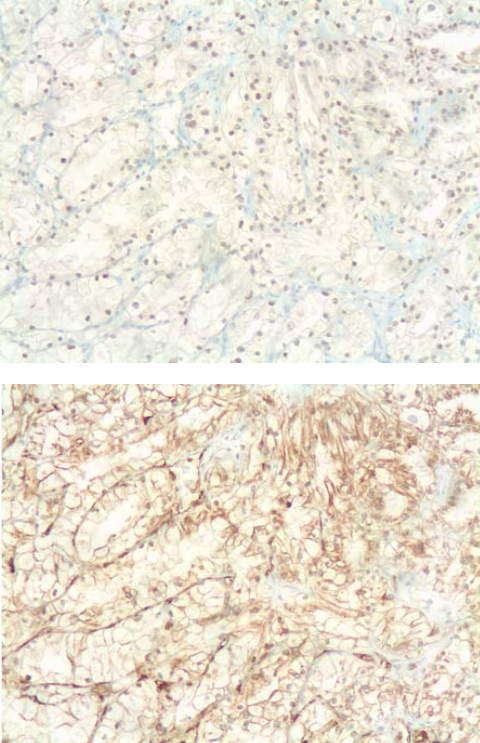
Figure 2. Nuclear HIF-1 α ( top ) and NQO1 ( bottom ) expression (brown staining) in serial